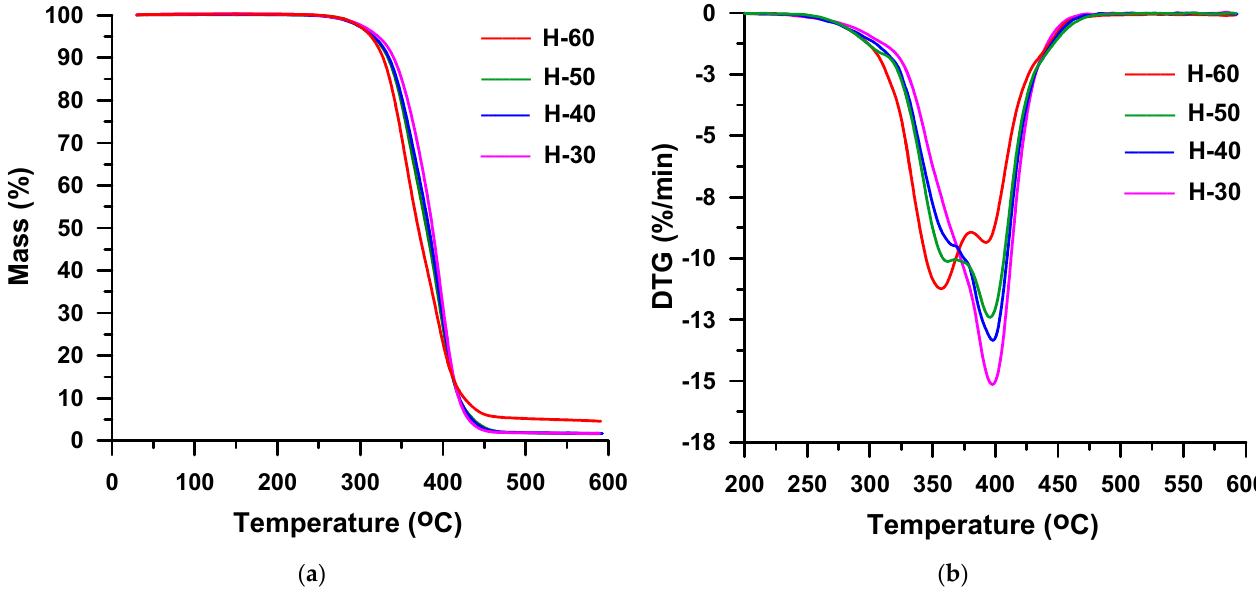
Figure 8. TG ( a ) and DTG ( b ) curves of the HDI-based TPU elastomers obtained in helium.